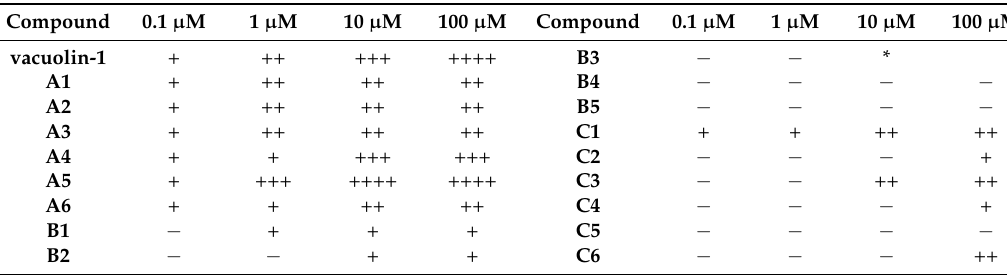
Figure 5. Synthesized vacuolin-1 analogues inhibited autophagic flux in HeLa cells. ( A ) A5 (1 µM), not C5 (1 µM), induced the accumulation of yellow LC3B-II puncta in RFP-GFP-LC3B expressing HeLa cells. Scale bar = 10 µm. ( B ) Treatment of HeLa cells with vacuolin-1 analogues (1 µM) and BAF (100 nM) failed to further increase the accumulation of both LC3B-II and SQSTM1 as compared to either drug alone.